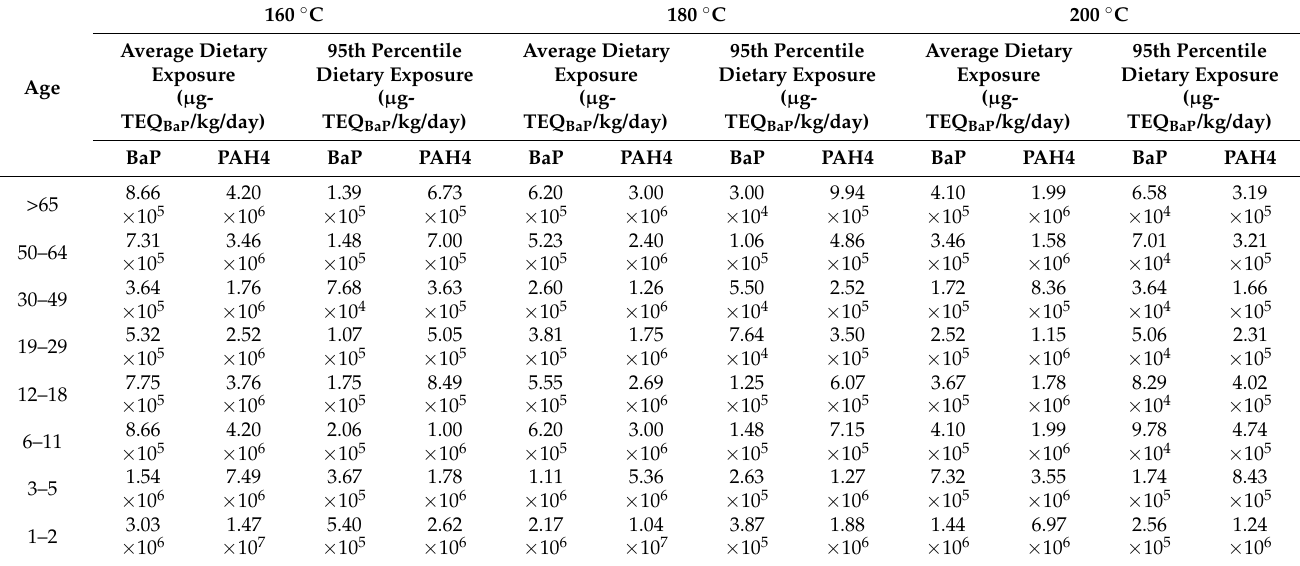
Table 6. Variation of MOE value by frying temperature for each age